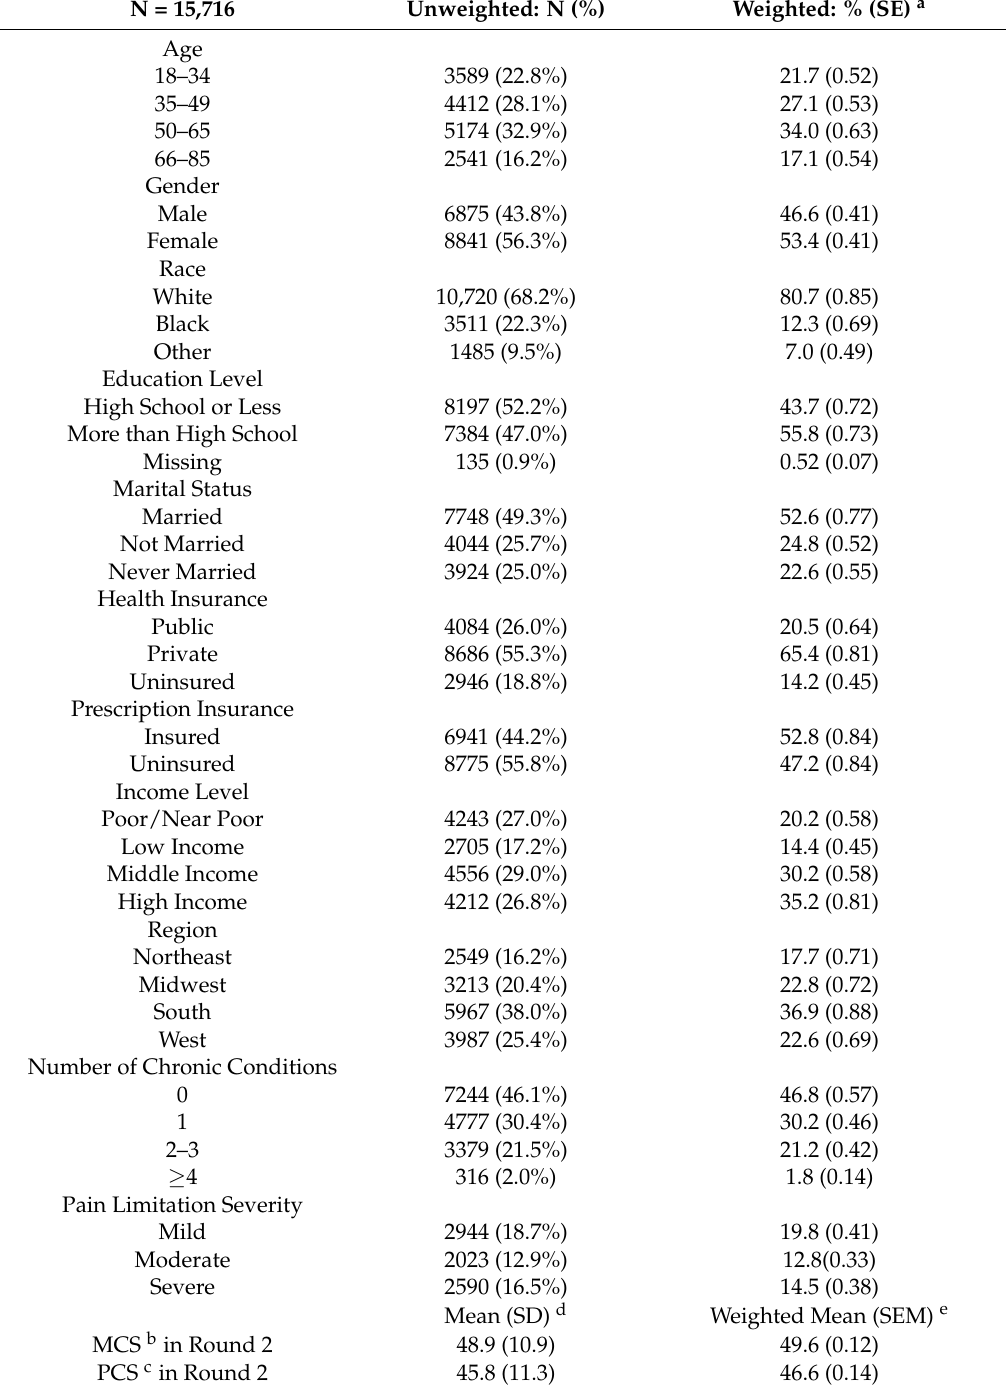
Table 1. Demographic Characteristics of Patients with Non-Cancer